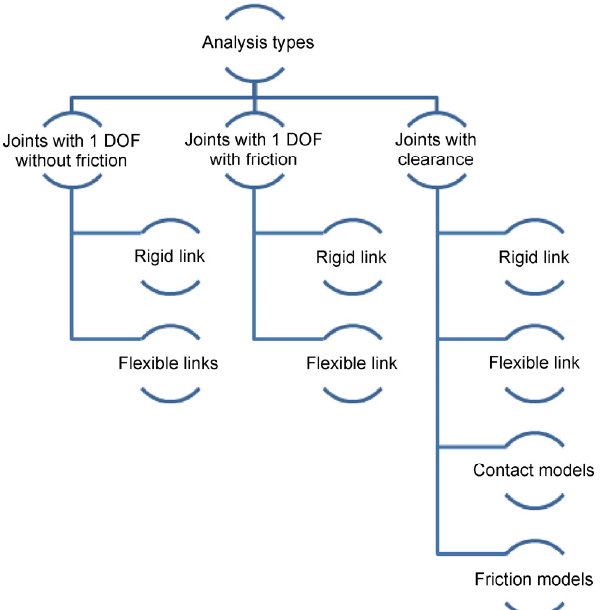
Fig. 8 Classification of manipulator dynamics research and